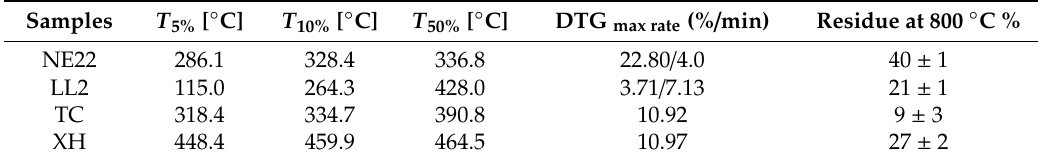
Table 7. T max for belt at di ff erent heating rates (10, 20, 30 ◦ C / min) under nitrogen